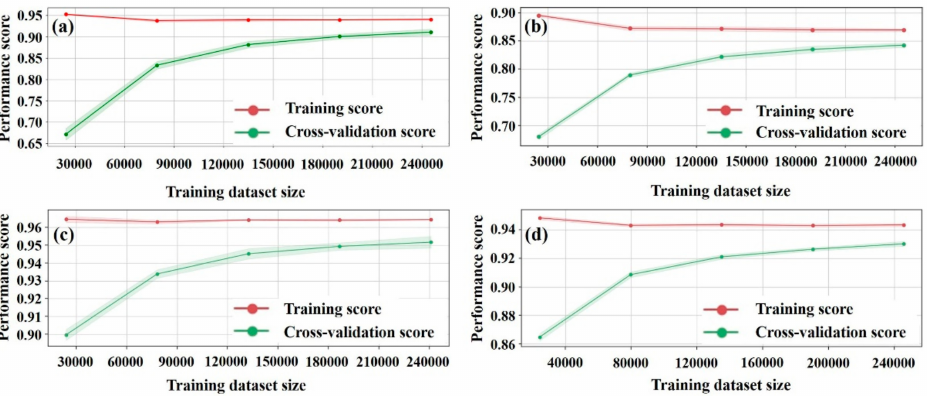
Figure 5. The learning curve of the geographical RF models for ( a ) PM 2.5 , ( b ) PM 10 , ( c ) O 3 , and ( d )